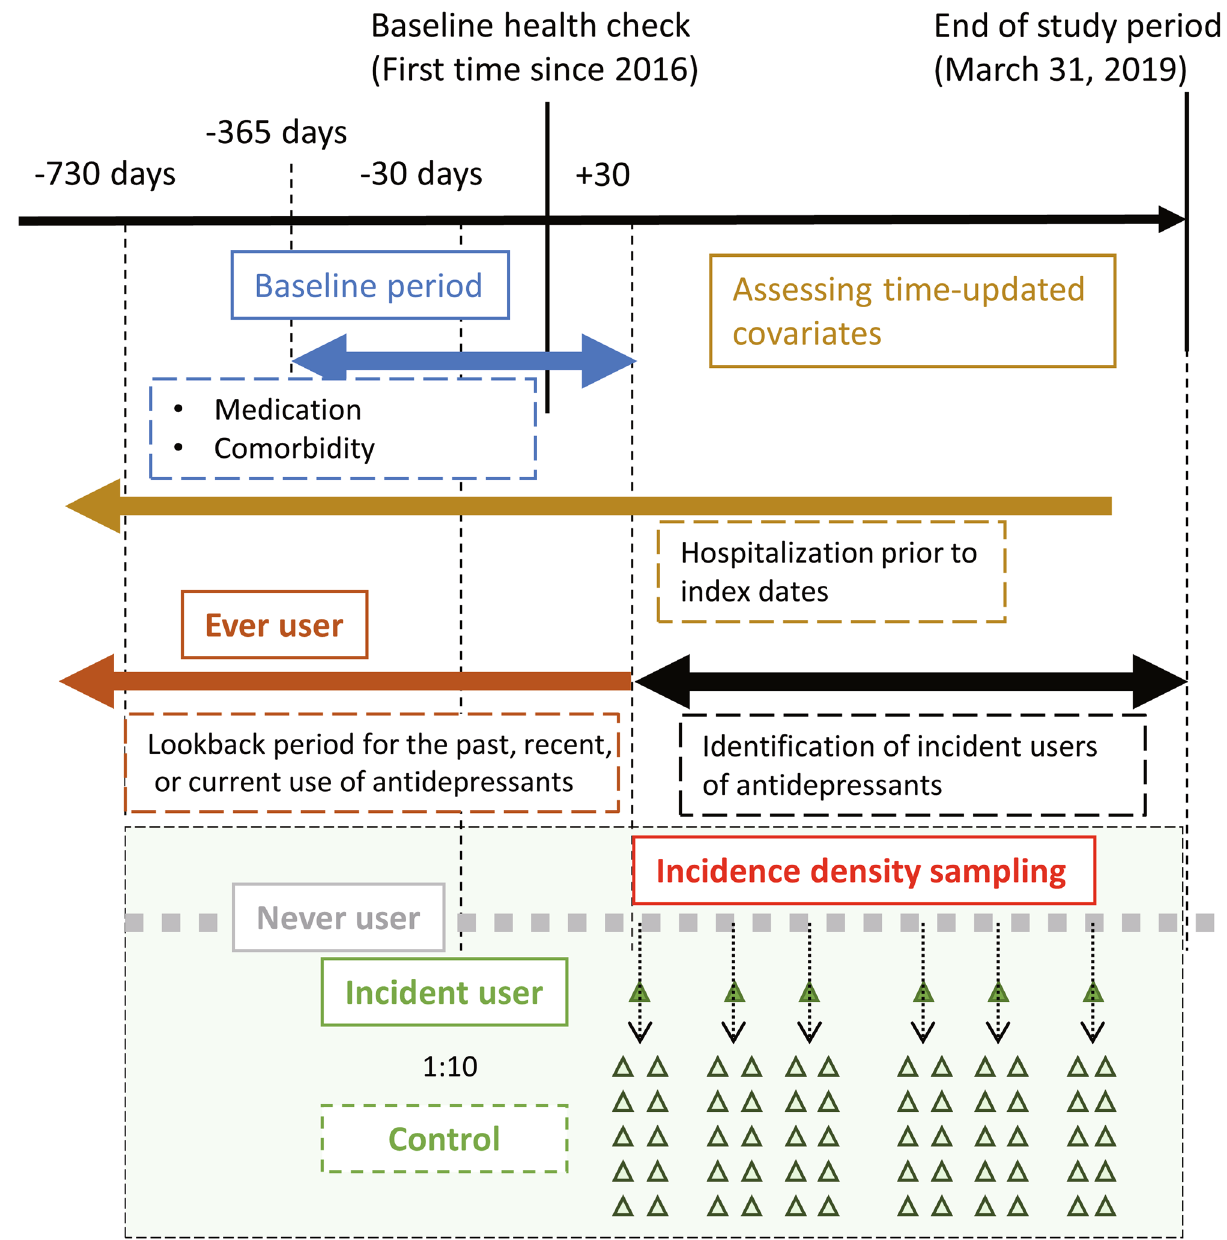
Incidence density sampling was performed to conduct a nested case–control